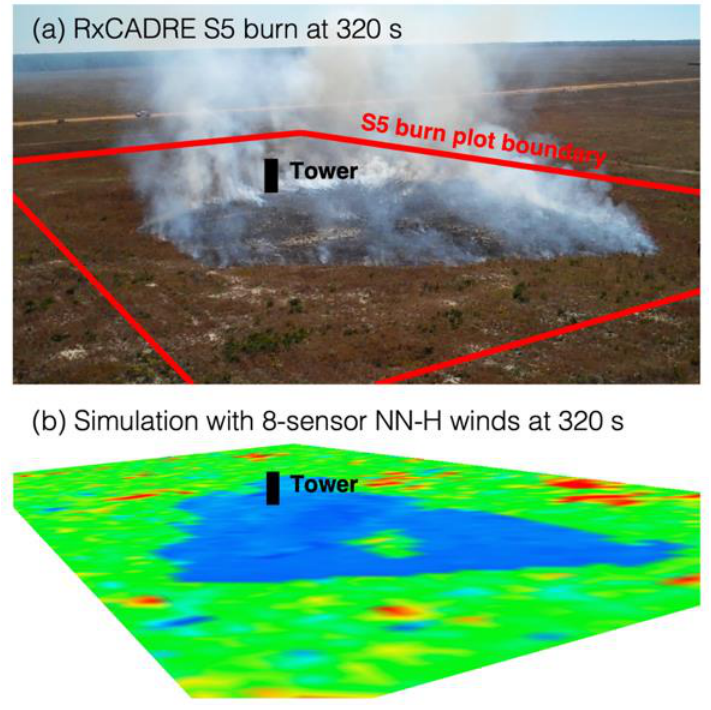
Figure 9. S5 burn from RxCADRE ( a ) and FIRETEC nearest neighbor simulation ( b ), both at 320 s after ignition. The red lines in the RxCADRE image show the extent of the FIRETEC computational grid. The black marker in the center of each image marks the location of an instrument tower. The large blue area in the FIRETEC image indicates the modeled burn area. A comparison between these images highlights obvious differences in fire progression.